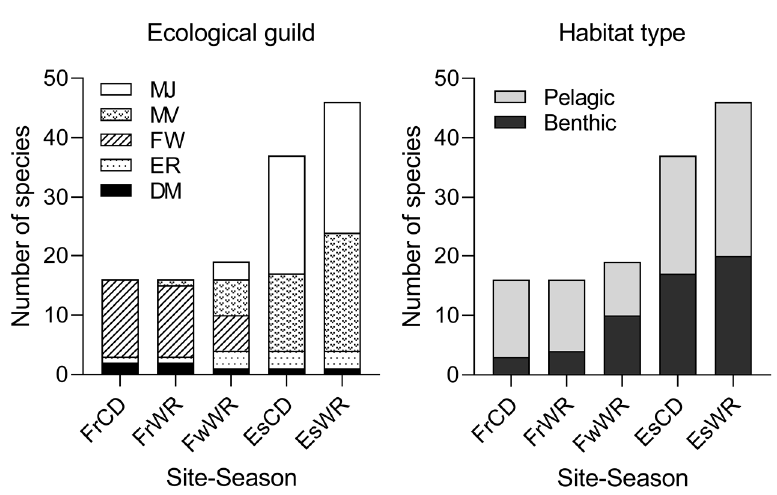
Figure 8. The number of species by ecological guild and habitat type in freshwater (Fr), fishway (Fw) and estuary (Es) sites during cold-dry (CD) and warm-rainy (WR) seasons; ecological guilds were estuarine residents (ER), freshwater species (FW), marine occasional visitors (MV), marine juveniles (MJ), and diadromous migrants (DM).